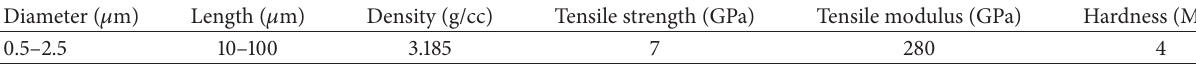
Table 1: Physicomechanical properties of potassium titanate whiskers.